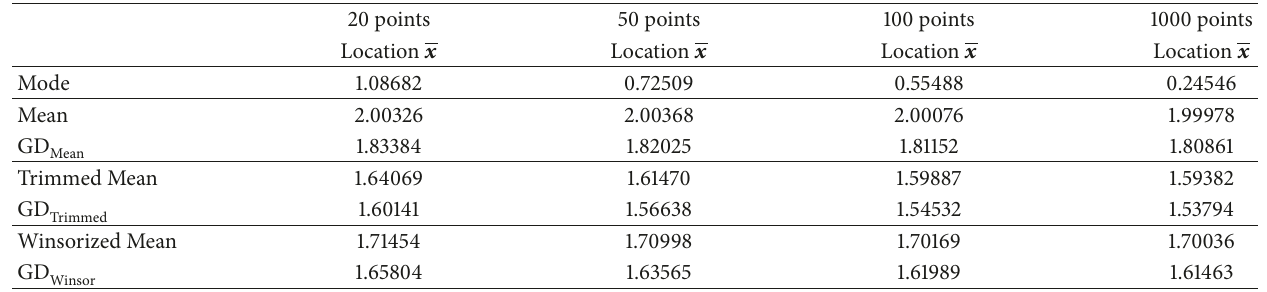
Table 26: Exponential distributions with 30% noise level.